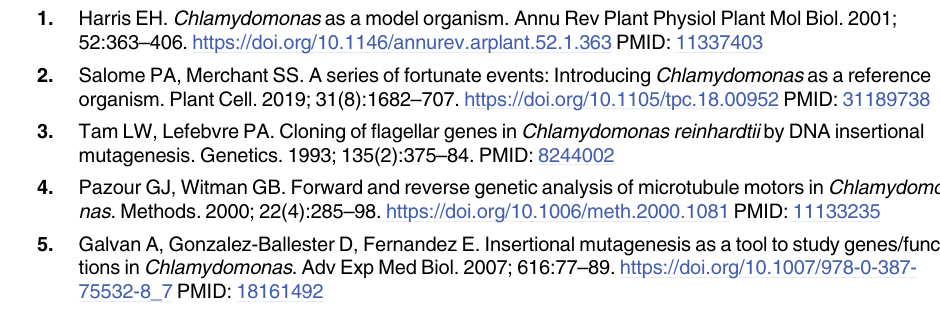
S1 Table. List of crRNA and primer sequences. S2 Table. Gene